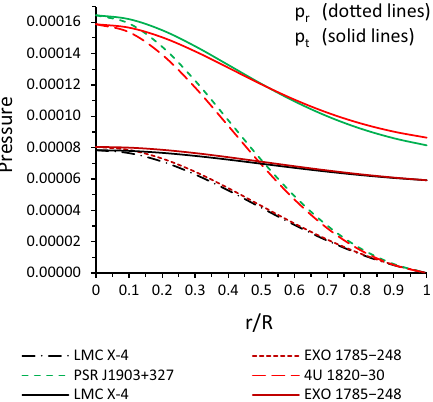
Fig. 2 Behaviour of energy density ρ ( left panel ), and radial pressure, p r dotted line, tangential pressure, p t solid line ( right panel ) vs. frac- tional radius r / R for LMC X-4, EXO 1785-248, PSR J1903+327 and